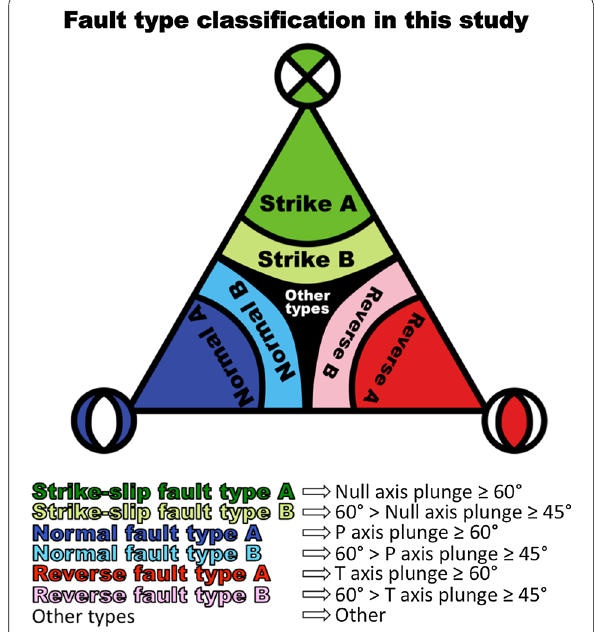
Fig. 3 Fault type classification in this study. The fault type classifica- tion scheme is similar to that of the triangle diagram proposed by Frohlich (1992), but we introduce two grades for each category based on the plunge of the axis. Grade A means that the focal mechanism has an axis with a plunge angle θ 60°, and grade B indicates a ≥ plunge angle of 45° θ < ≤